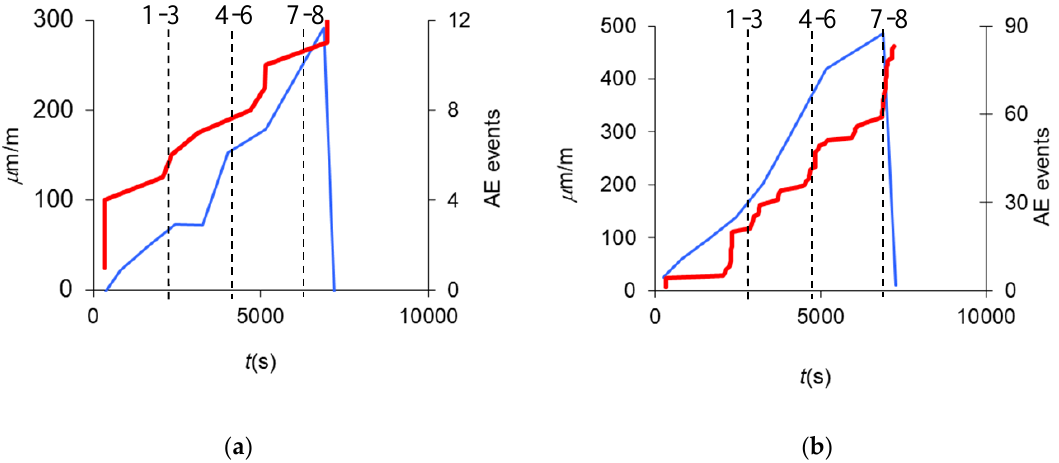
Figure 13. Cumulative AE activity and FOS strain time histories for: ( a ) fiber optic n.7 at x = − 1.6 m and AE sensor n.0; ( b ) fiber optic n.7 at x = − 1.2 m and AE sensor n.1. The dashed lines identify the different loading stages.